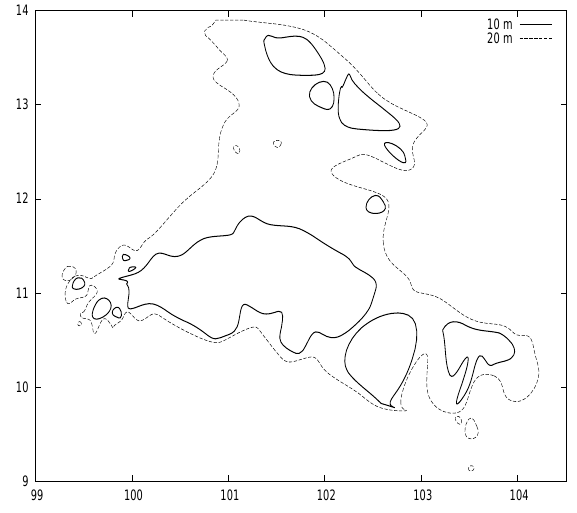
Figure 7: Boundary contours before generalisation. Units in cm